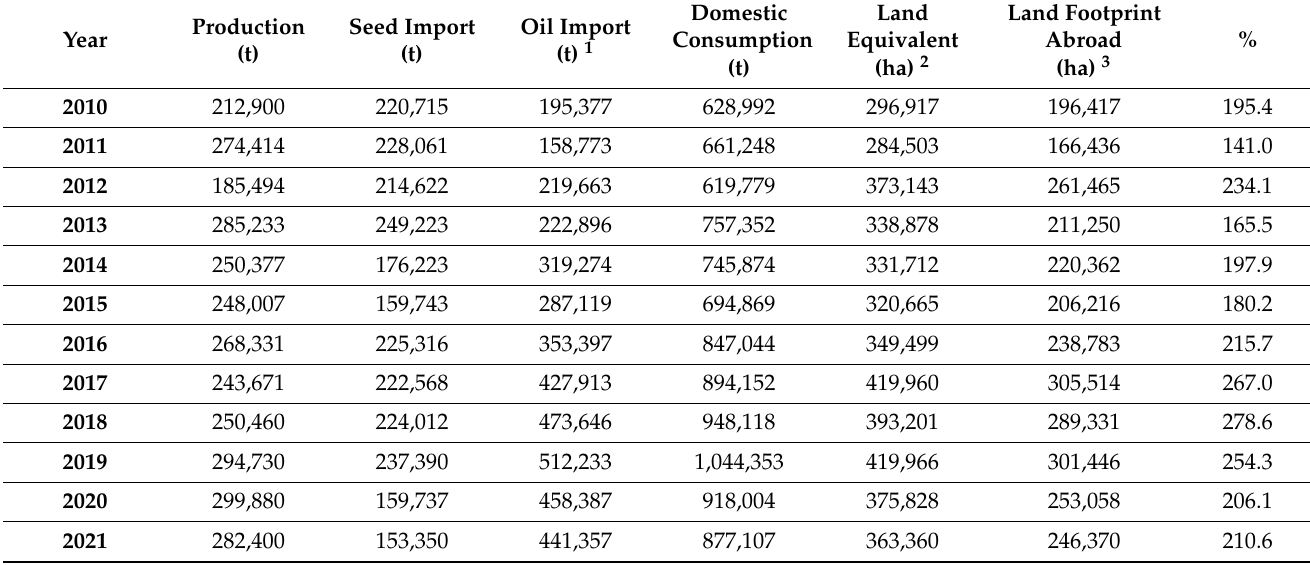
Table 3. Domestic consumption of sunflower products and impact on land use